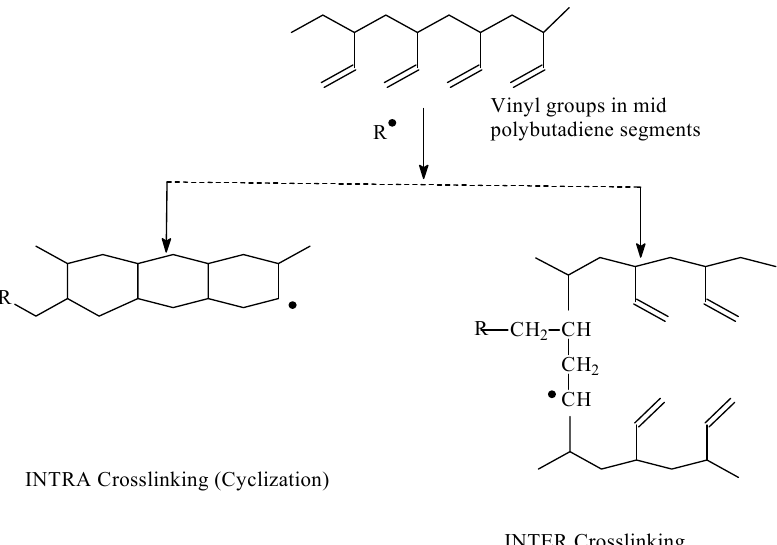
Scheme 2. Plausible reaction scheme of vinyl functionality in the butadiene segments.